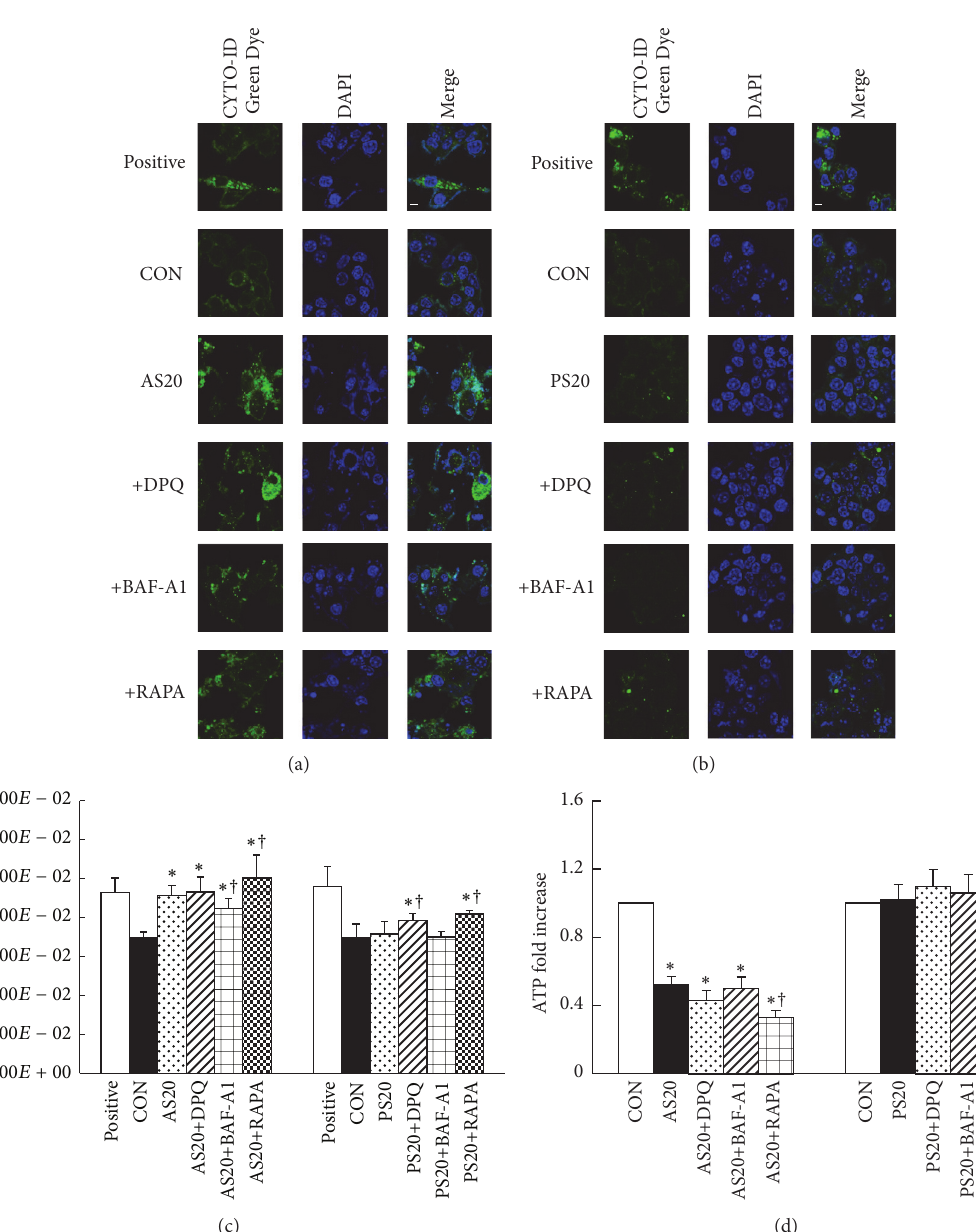
Figure 5: Role of PARP1 expression in the induction of AS and PS autophagy. (a) CYTO-ID (cid:3) Green Dye staining revealed significantly increased LC3-II accumulation (green) in AS-treated NIT-1 cells compared with untreated cells; decreased LC3-II accumulation was observed after treatment with the BAF-A1 inhibitor; increased LC3-II accumulation was observed after treatment with the DPQ and RAPA inhibitors. Rapamycin is included as positive control. (b) No significant difference was found in the accumulation of LC3-II between control and PS- treated or PS+BAF-A1-treated NIT-1 cells, remaining high after DPQ or RAPA pretreatment. Chloroquine is included as positive control. Magnification: × 60. Scale bar: 20 𝜇 M. (c) Quantification of the CYTO-ID Green Dye stain in NIT-1 cells per 600x fields for six fields per group. A significantly high number of LC3-II-positive cells were observed in the AS20, AS20+DPQ, and AS20+RAPA groups. (d) Cells treated with AS also showed a decreased ATP level, indicating that AS promoted ATP depletion in NIT-1 cells. DPQ significantly reduced the cellular ATP level. PS treatment for 48 h did not change the cellular ATP level and only mildly increased the ATP level after DPQ pretreatment. No significant difference was found compared with the untreated control group ( ∗ 𝑃 < 0.05 , compared to the untreated group; † 𝑃 < 0.05 , compared to the only AS- or PS-treated group; mean ± SD from three replicates). The value for the CON group was set at